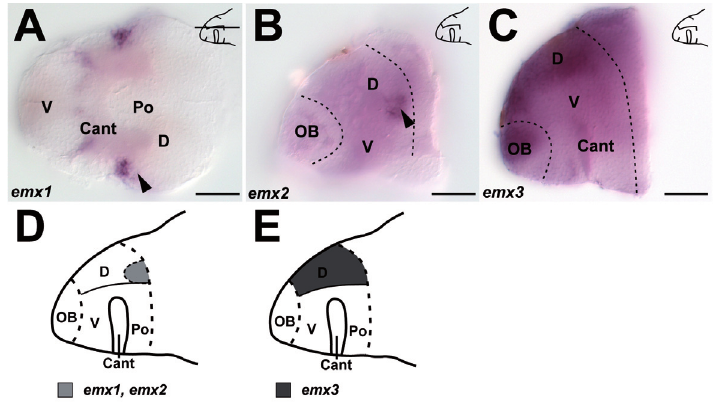
Figure S3. Expression of emx1 , emx2 and emx3 in the zebrafish larval brain at 7dpf. A . emx1 expression is present in the lateral part of the dorsal telencephalon ( D , arrowhead), shown is a ventral view. B . emx2 expression is present in the lateral part of D (arrowhead), shown is a parasaggital view. C . emx3 expression is present throughout D , shown is a parasaggital view. D . Summary of the distribution of emx1 and emx2 expression in D in a sagittal view. E . Summary of the distribution of emx3 expression in D in a sagittal view. A .– C . Brightfield whole- mount images, A . ventral, B .– C . sagittal views. Scale bars = 50µm A – C